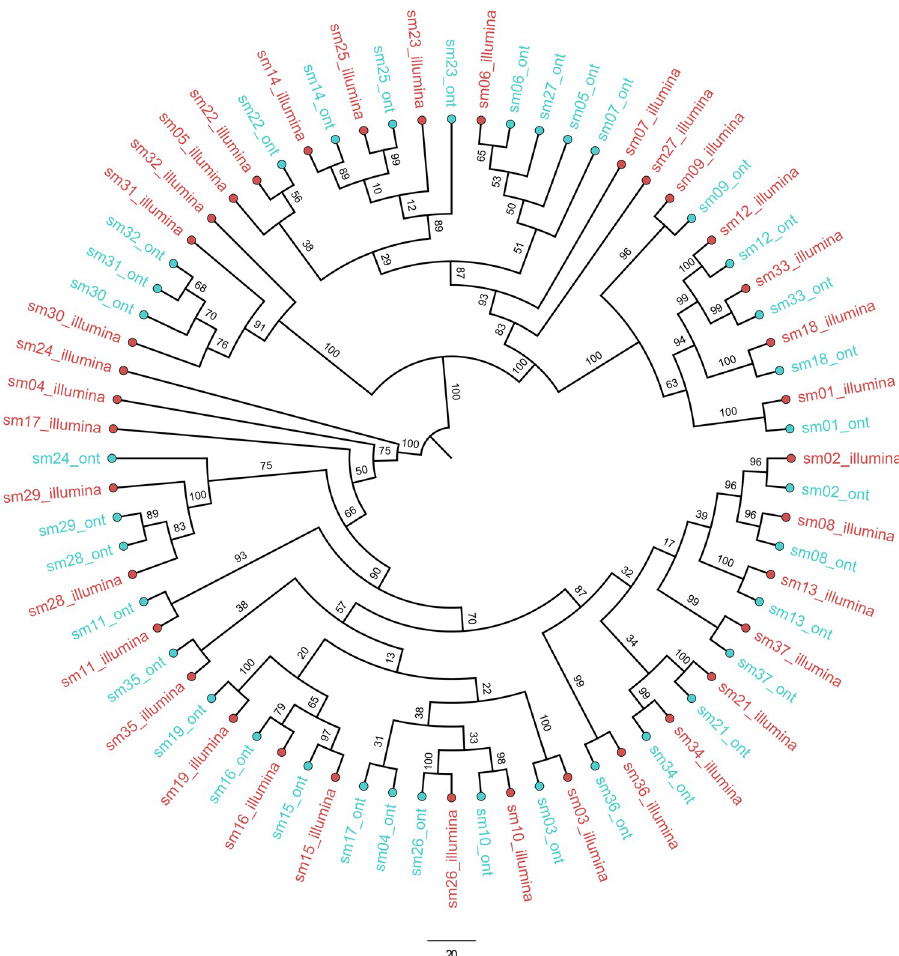
Fig 4. Combined maximum likelihood phylogenetic tree created using sequence pairs of 37 the samples. The ML tree was generated using the consensus sequences of each sequencing technology with 1000 bootstrap replicates using TIM2+F+R2 model. Tree is rooted on SARS-CoV-2 reference MN908947.3 and with samples sequences by Illumina coloured red and those sequenced by ONT coloured blue. Bootstrap support values are shown on each branch. 21/37 samples coupled together with < 98% bootstrap support had > 90% genome coverage from both Illumina and ONT datasets while 7/37 samples coupled together with less than 98% bootstrap support. 9/37 of the samples which failed to couple with their counterpart from ONT or Illumina had moderate to high (3% - 31%) ambiguous bases in either